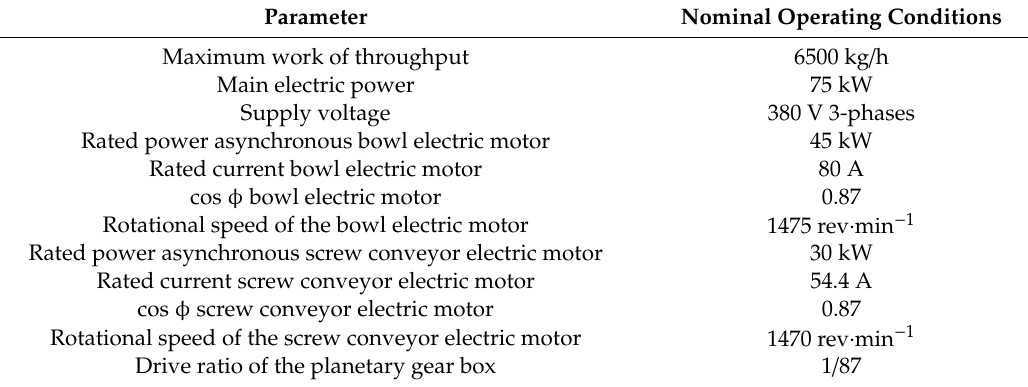
Table 1. Parameter values and nominal operating conditions for the decanter